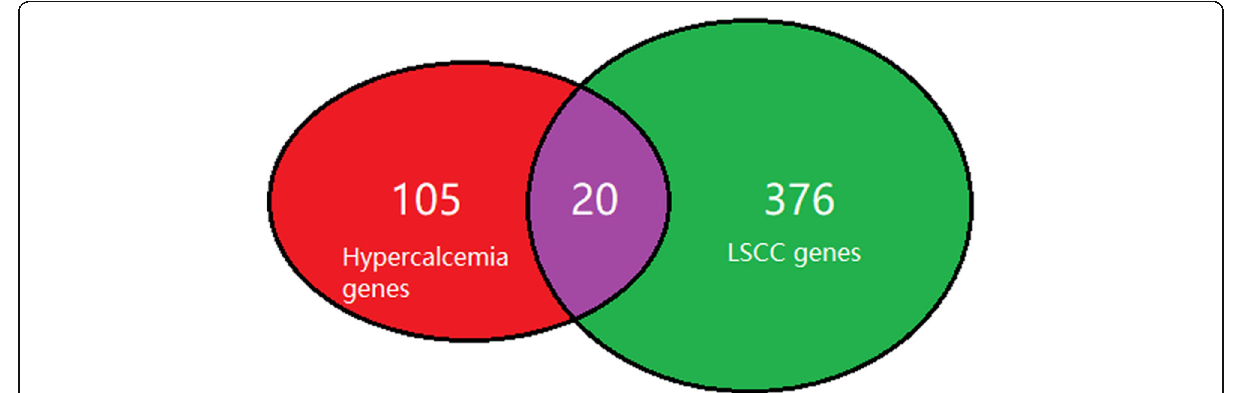
Fig. 1 Venn diagram of the genes implicated with hyperkalemia and lung squamous cell